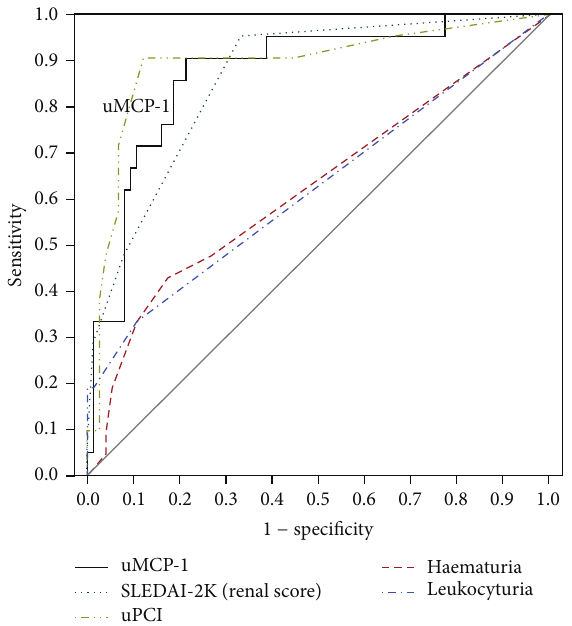
Figure 2: Receiver operating characteristic curve (ROC) of uMCP-1 compared with those of urinary parameters and SLEDAI-2K (renal) for the diagnosis of LN activity at 4 months. The black solid curve represents the uMCP-1; the area under the curve (AUC) was 0.87 ( 𝑝 < 0.001 ). The AUC for proteinuria was 0.89 ( 𝑝 < 0.001 ) and those for haematuria and leukocyturia were 0.62 ( 𝑝 = 0.07 ) and 0.62 ( 𝑝 = 0.08 ), respectively. The AUC for SLEDAI-2K was 0.85 ( 𝑝 < 0.001 ). Thus, uMCP-1 was better than haematuria and leukocyturia and essentially similar to proteinuria (uPCI) and SLEDAI-2K renal score for detection of LN activity at 4